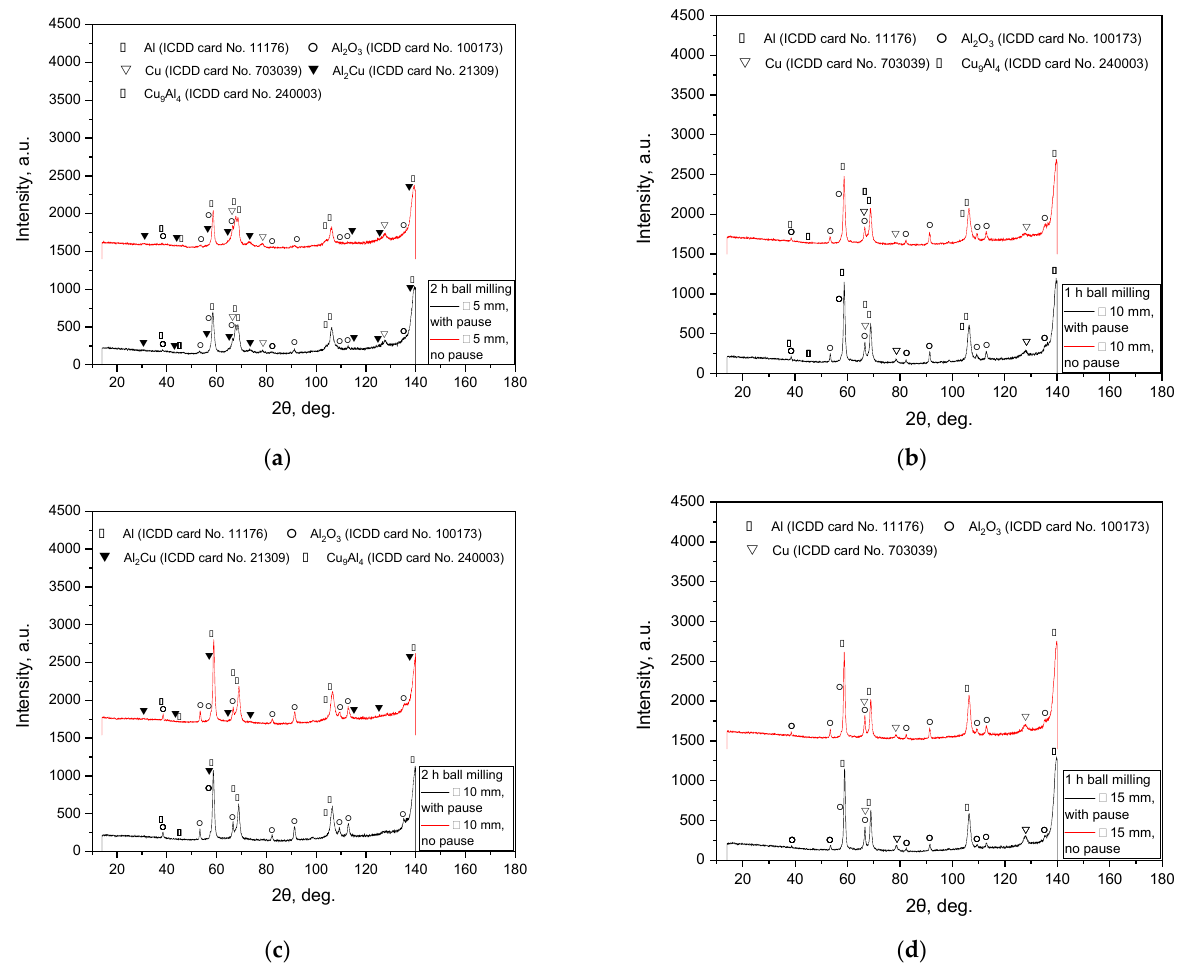
Figure 1. XRD patterns of the samples with different ball milling parameters: ( a ) 2 h, 5 mm steel balls; ( b ) 1 h, 10 mm steel balls; ( c ) 2 h, 10 mm steel balls; ( d ) 1 h, 15 mm steel balls.